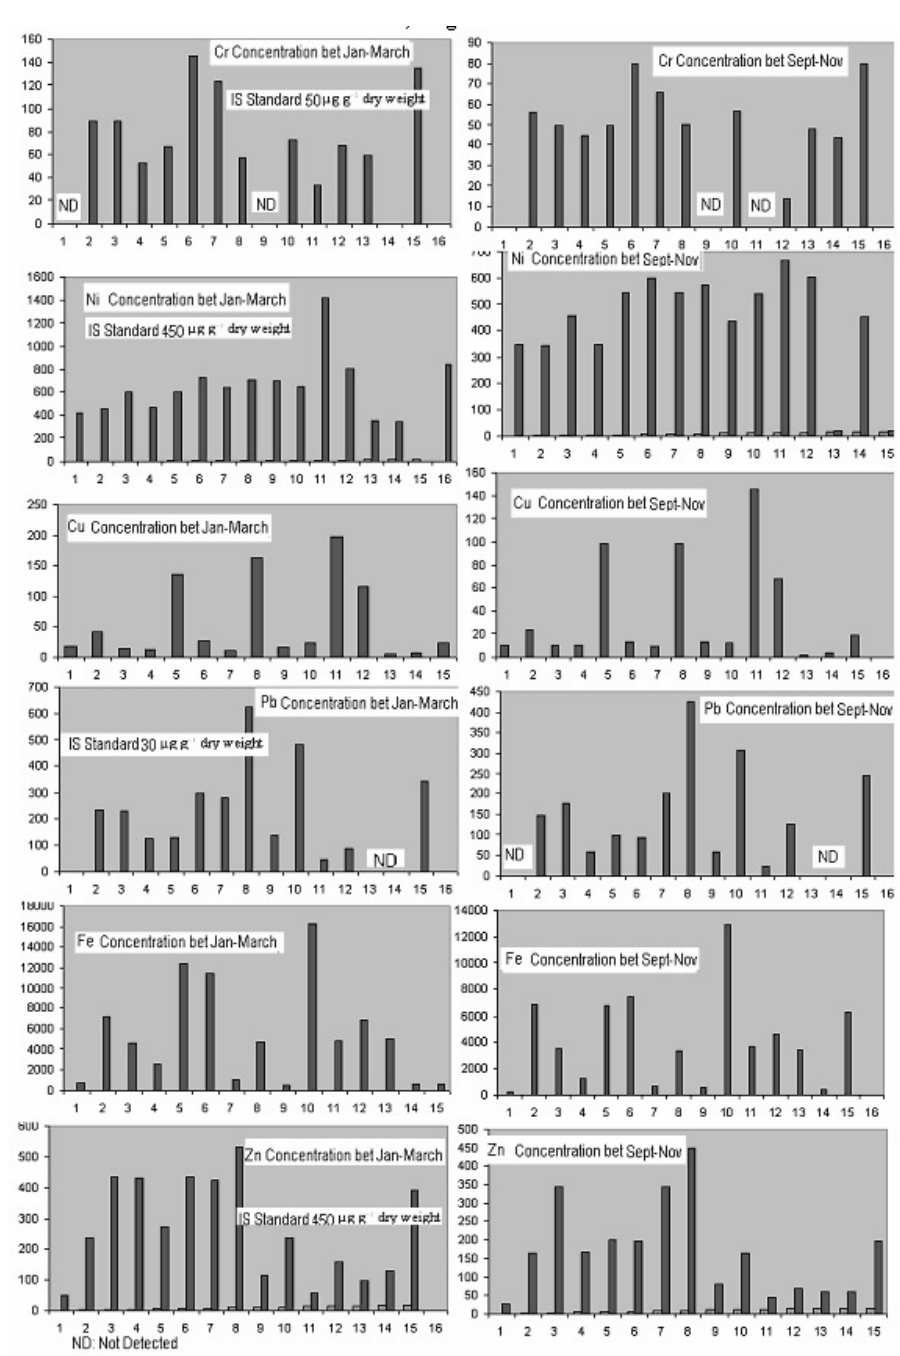
Figure 3 . Heavy metal concentration µg g -1 dry weight in soils of Hosur Road, Bangalore